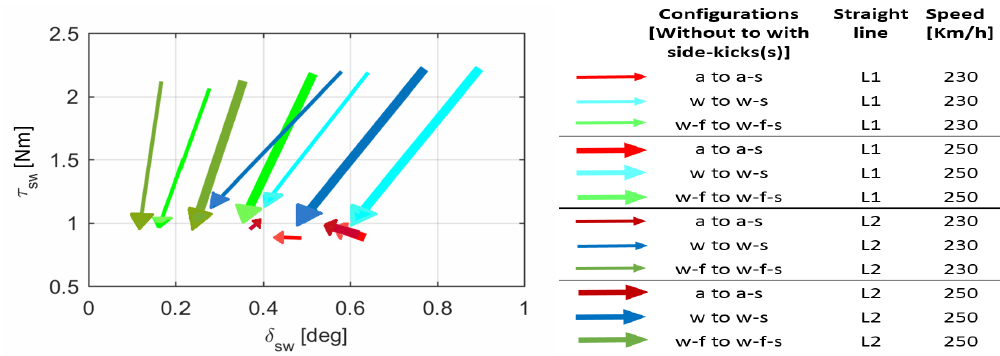
Figure 8. Mean vector plot steering torque τ sw vs steering angle δ sw of each straight line L1 & L2 for the different configurations and